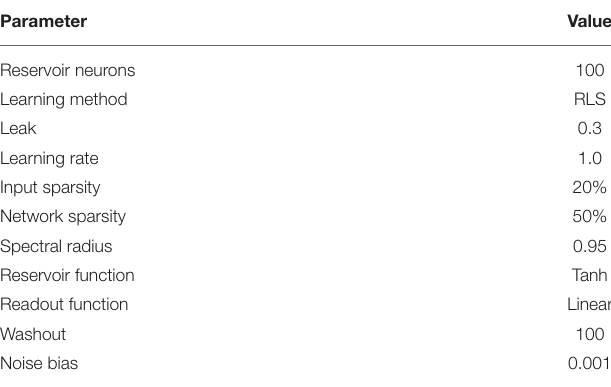
TABLE 1 | Echo State Network parameters which provided the best